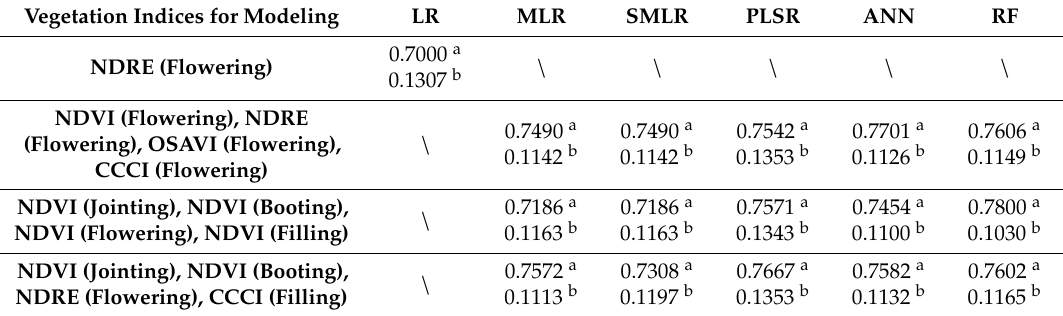
Table 5. Validation of yield estimation models with simple linear regression (LR), multiple linear regression (MLR), stepwise multiple linear regression (SMLR), artificial neural network (ANN), and random forest